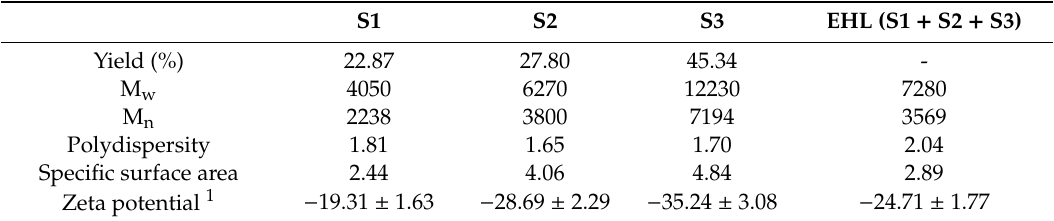
Figure 1. ( a ) Procedure for stepwise ethanol-water fractionation of enzymatic hydrolysis lignin (EHL), inset: pictures of S1, S2, S3, and EHL; ( b ) Molecular weight distributions of S1, S2, S3, and EHL; ( c ) FTIR spectra of S1, S2, S3, and EHL. Table 1. Yield, molecular weight distribution, specific surface area and Zeta potential of lignin subdivisions, as well as those of enzymatic hydrolysis lignin